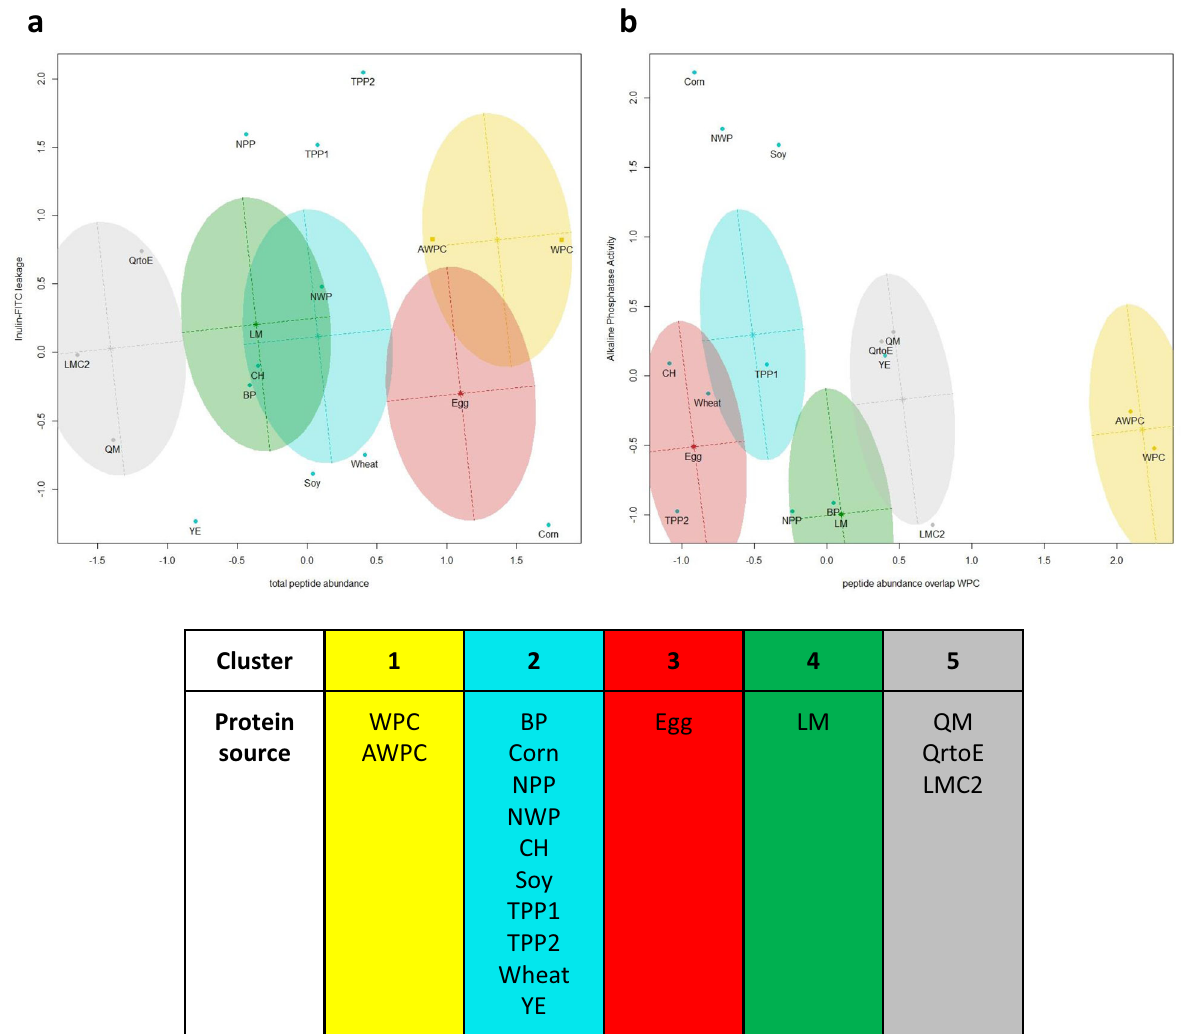
Fig. 3 Holistic clustering of potential dietary protein based on proteomic and intestinal biological ef fi cacy data. The optimal statistical cluster model ellipsoidal, equal volume, shape, and orientation (EEE) and number of clusters (5) were determined using the Bayesian Information Criterion. Considered data were peptide abundance, total amount of unique peptides, relative overlap with whey protein concentrate (WPC), the relative peptide abundance of the WPC overlap, inulin-FITC leakage, ZO-1 quanti fi cation, cell viability, alkaline phosphatase activity, IL-6, TGF β , and nitric oxide. a two-component plot showing inulin-FITC leakage assay on the vertical axis and total peptide abundance on the horizontal axis. b two-component plot showing alkaline phosphatase activity assay on the vertical axis and relative peptide abundance of WPC overlapping peptides on the horizontal axis. Supplementary Fig. 11 shows all combinations of two-component plots. The division of potential dietary proteins in the different clusters is shown below the two two-component plots. Analysis was done based on proteomic data and biological ef fi cacy